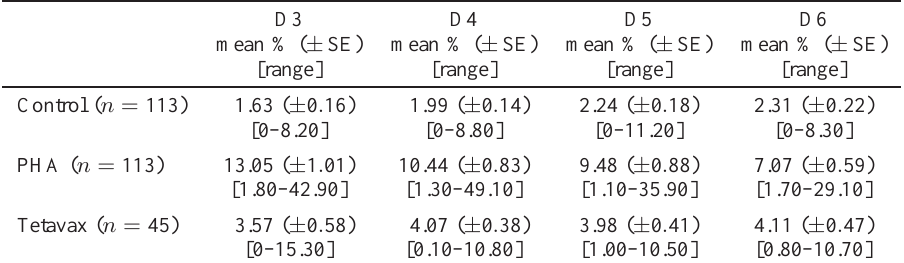
Table 1 Sequential assessment of the percentage of cells in the S phase among peripheral blood mononuclear cells cultured for 3, 4, 5 or 6 days with medium alone, PHA or Tetavax